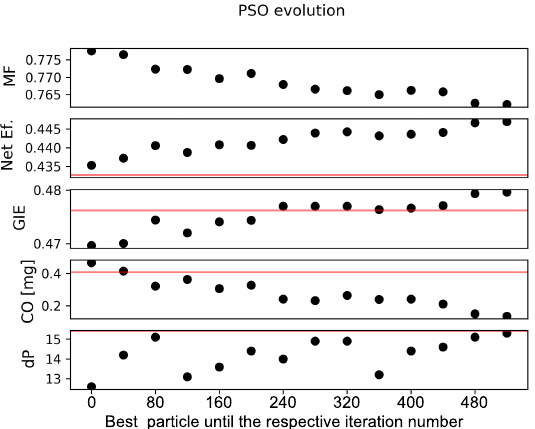
Figure 14. Evolution of the optimum particle after different